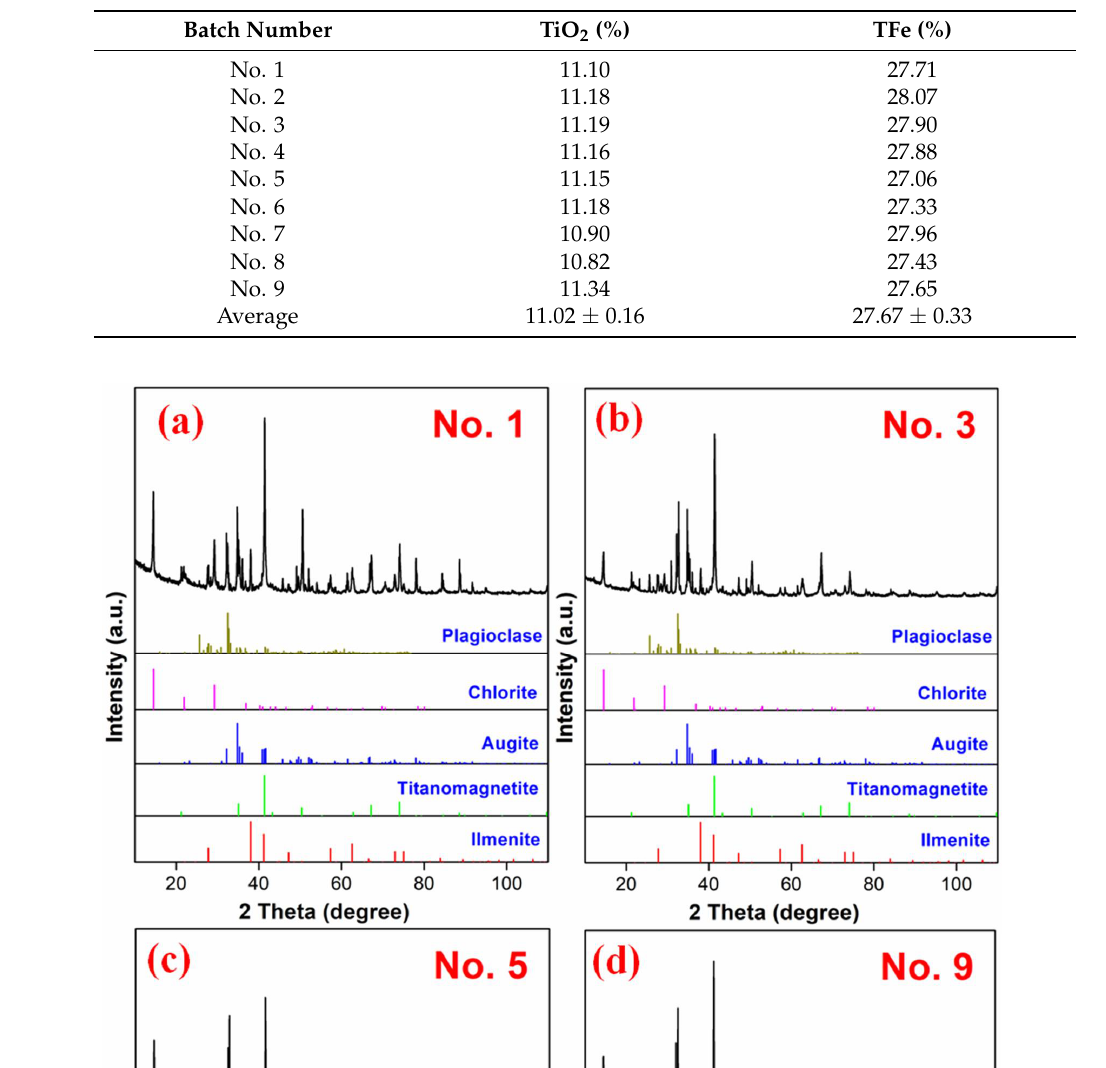
Figure 1. XRD results for different ore samples: ( a ) No. 1, ( b ) No. 3, ( c ) No. 5, and ( d ) No. 9.